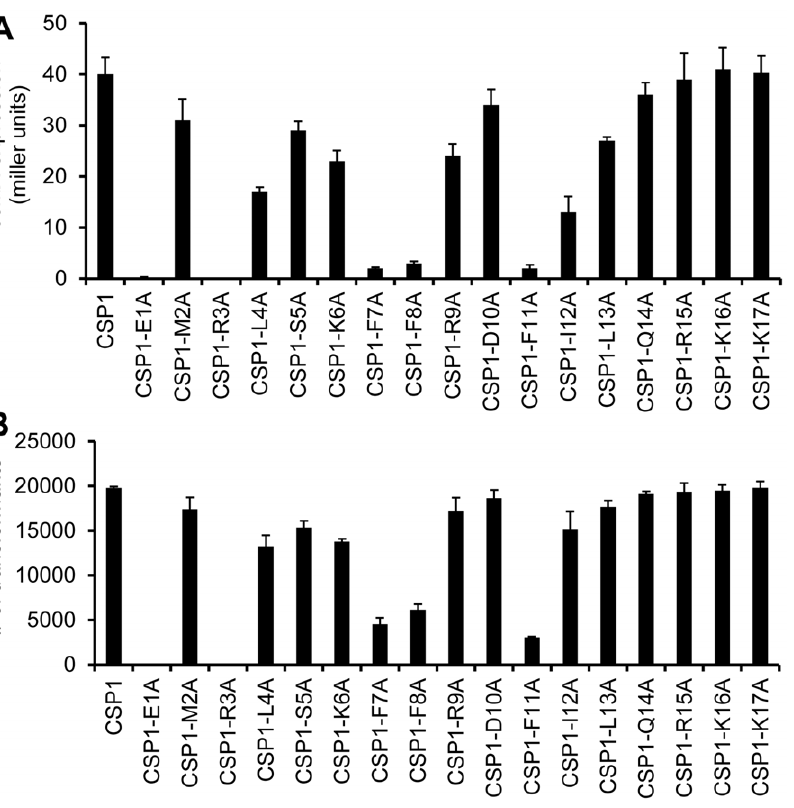
Figure 2. Analyses of the ability of CSP1 analogs to induce comX expression and genetic transformation. Pneumococcal cells were incubated with CSP1 or with each analog at a final concentration of 100 ng/ml. The ability of each peptide to induce the competence regulon was measured by induction of the comX expression using the ß-galactosidase assays in D39pcomX:: lacZ cells (A) or by genetic transformation using the rpsL gene in D39 cells (B). Transformants were selected on THB agar containing 100 m g/ml streptomycin. Experiments were performed in triplicates and repeated three times. The means 6 SD of one typical experiment are shown.